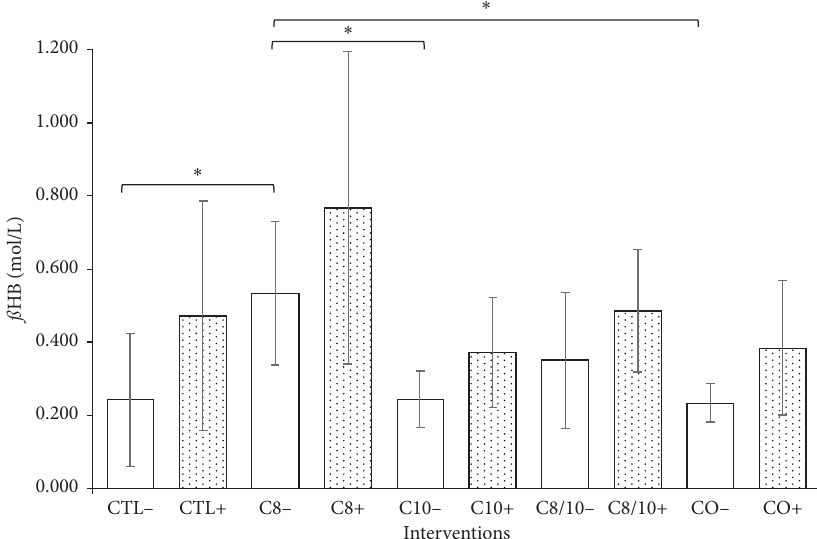
Figure 2: Mean and standard deviation of the ß HB concentrations of all interventions. Interventions with caffeine are highlighted. Interventions CTL − vs. C8 − ( p � 0 . 015), C8 − vs. C10 − ( p � 0 . 008), and C8 − vs. CO − ( p � 0 . 004) showed significant differences ( ∗